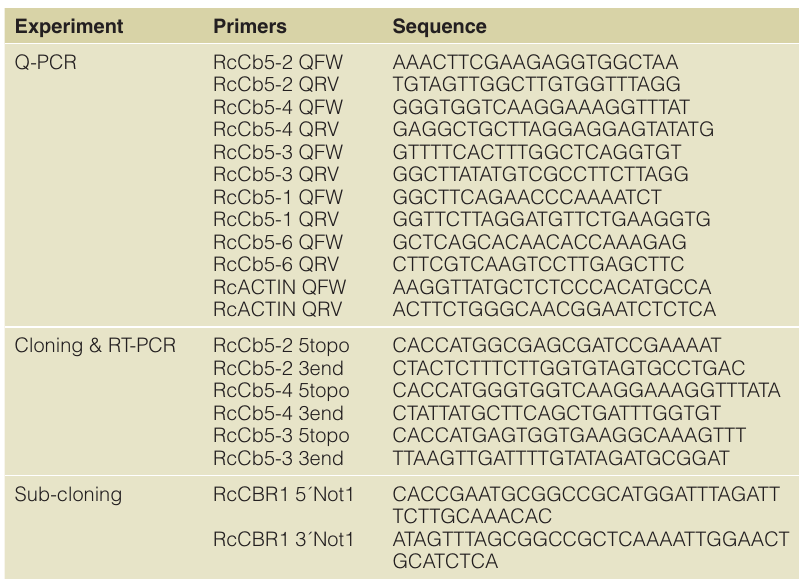
Table S1. List of primers used in